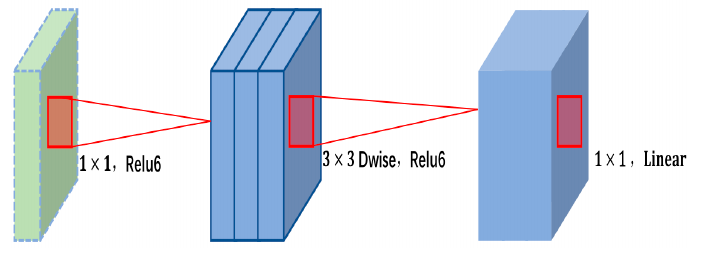
Figure 4. Linear Bo tt leneck